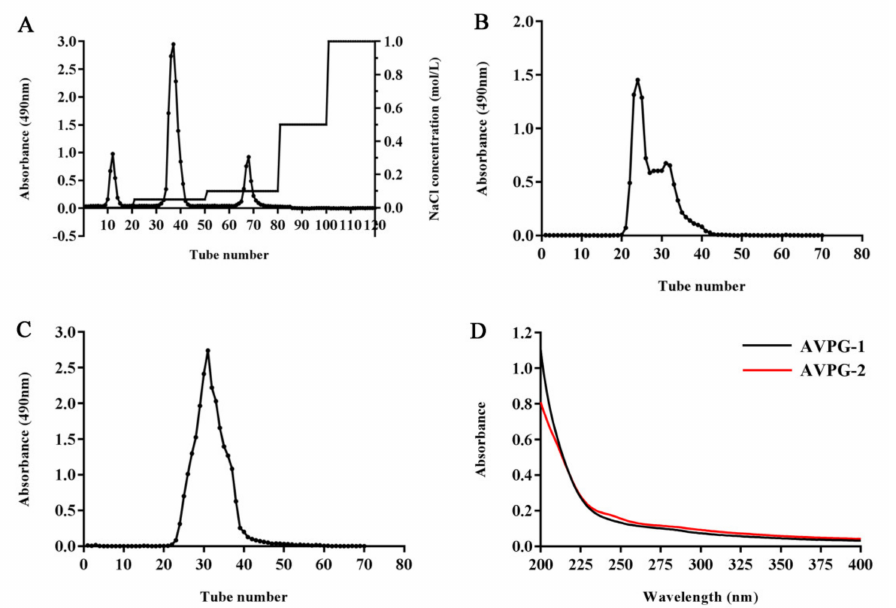
Figure 1. Elution curve of A. villosum polysaccharides (AVPs) on DEAE-52 column ( A ). Elution curve of AVPG-1 ( B ) and AVPG-2 ( C ) on Sephadex G-100 gel chromatography column. Ultraviolet (UV) spectra ( D ) of AVPG-1 and